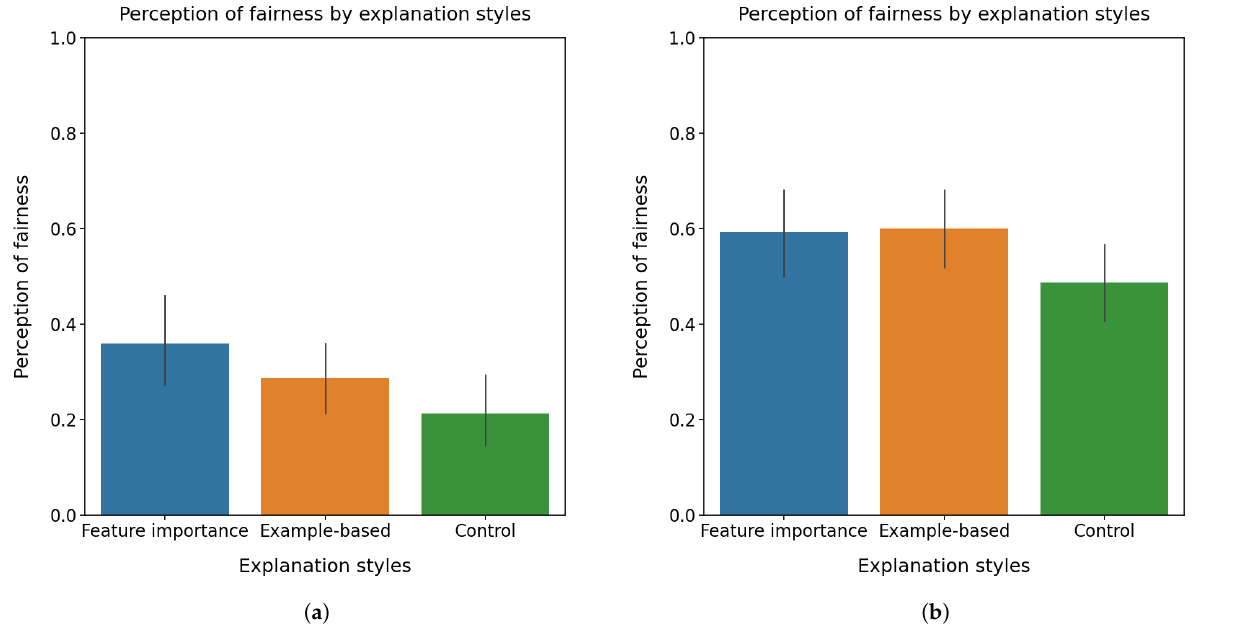
Figure 8. Effect of explanation types on the perception of fairness. ( a ) effect of explanation types on perception of fairness under low level of introduced fairness; ( b ) effect of explanation types on the perception of fairness under the high level of introduced